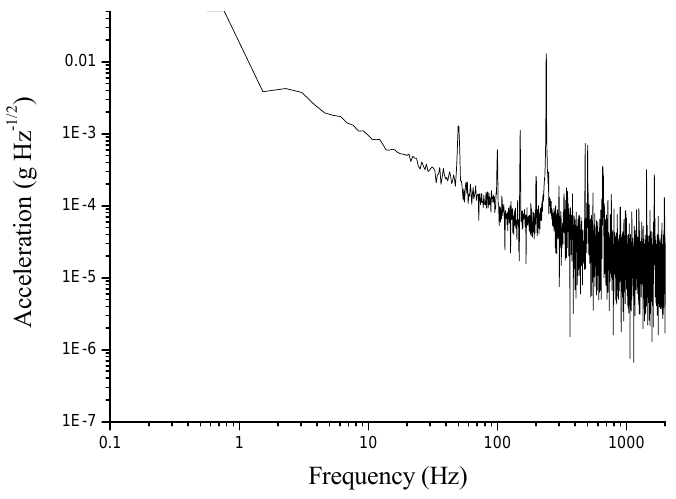
Figure 16. The acceleration noise spectral density along one axis of the accelerometer. A known deformation is applied by a PZT attached to the accelerometer and aligned with the measurement direction to enable the conversion of the sensor’s voltage signal into